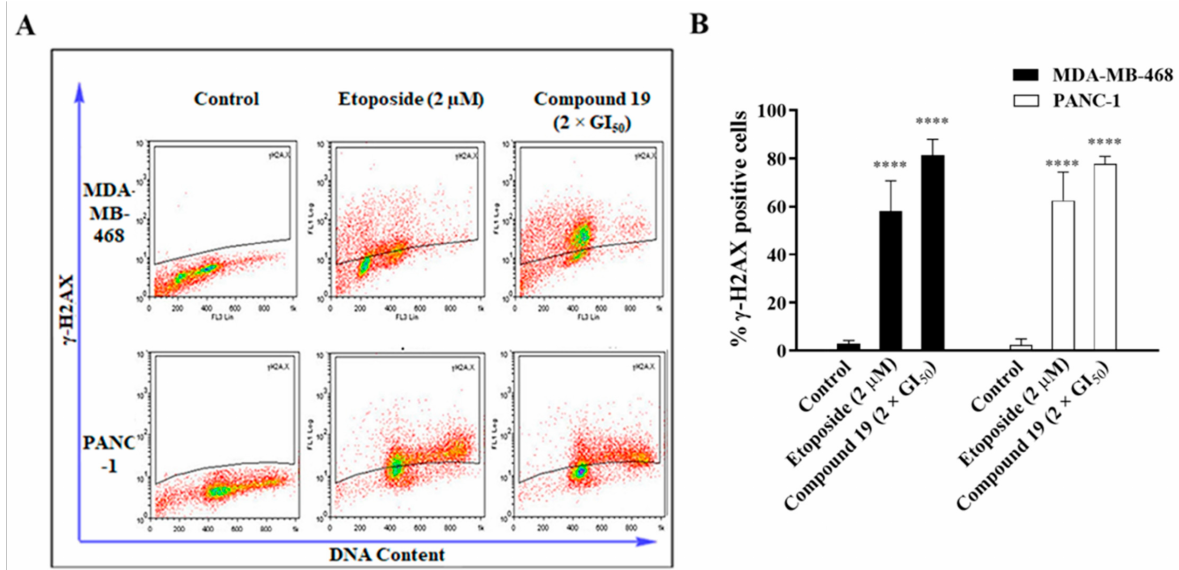
Figure 6. ( A ) Representative dot plots illustrating the formation of γ -H2AX in MDA-MB-468 and PANC-1 cells after 24 h of treatment with etoposide and 19 at concentrations of 2 µ M and 2 × GI 50 , respectively. ( B ) The experiment was repeated three times. Bars and error bars refer to the mean ± SD. **** p < 0.0001 vs.